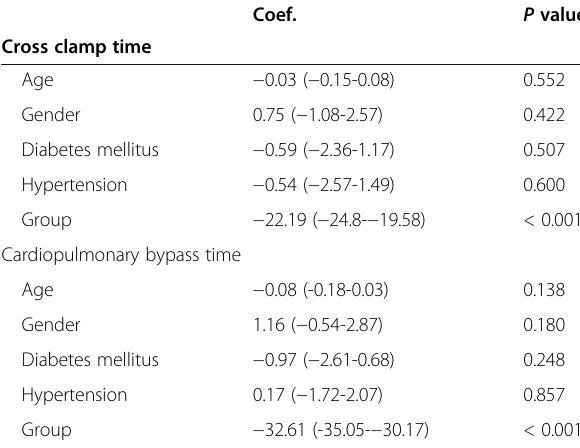
Table 2 Multivariable analysis of factors affecting cardiopulmonary bypass and ischemic times Coef.